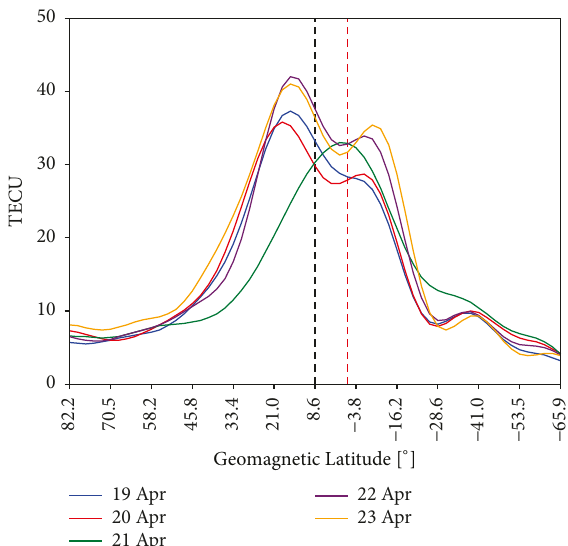
Figure 6: Shape of the VTEC for the 100 ∘ W meridian at 00:00 UT between April 19 and 23, 2018. A relevant range of geomagnetic latitudes is shown, 82.2 ∘ N - 65.9 ∘ S (75 ∘ N - 75 ∘ S in geographic latitudes). The vertical red and black dashed lines indicate the magnetic equator and the equator (geographic latitude = 0 ∘ ),